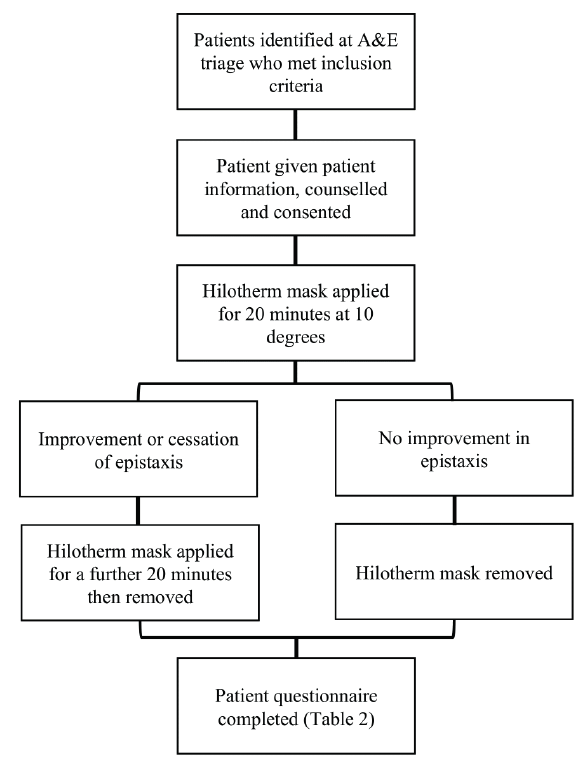
Figure 2. Pilot study flowchart.